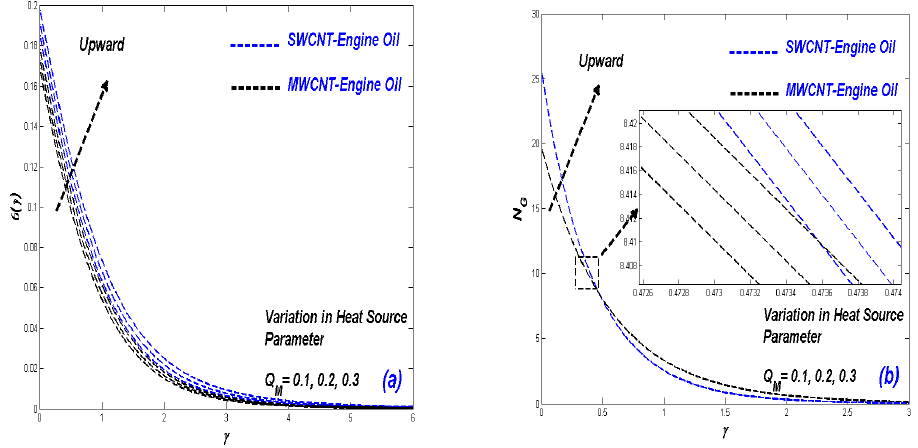
Figure 12. ( a ) Temperature change with Q M ; ( b ) Entropy change with Q M .